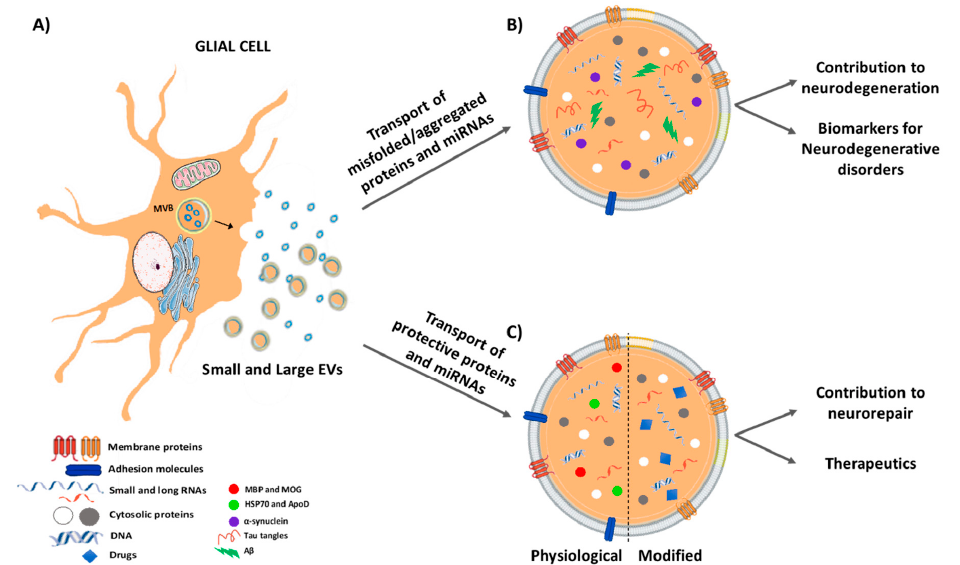
Figure 3. Contribution of extracellular vesicles secreted by glial cells in glia-neuron crosstalk; (A) Schematic representation of a glial cell releasing EVs, both exosomes (via fusion of MVBs with the plasma membrane) and shedding vesicles (directly released outside the cell). (B) In